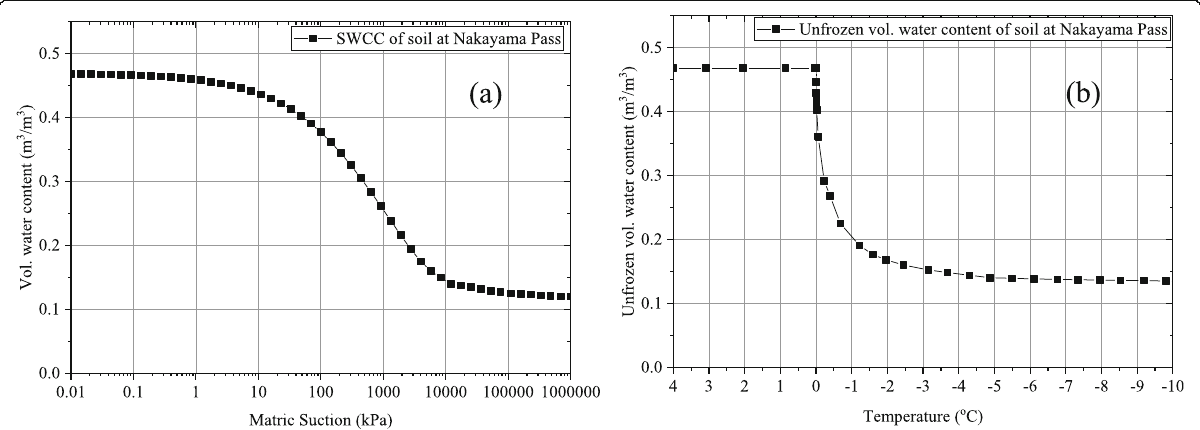
Fig. 7 Soil water characteristic curve (SWCC) and unfrozen volumetric water content function of soil at Nakayama Pass ( a ) SWCC, ( b ) unfrozen volumetric water content vs.